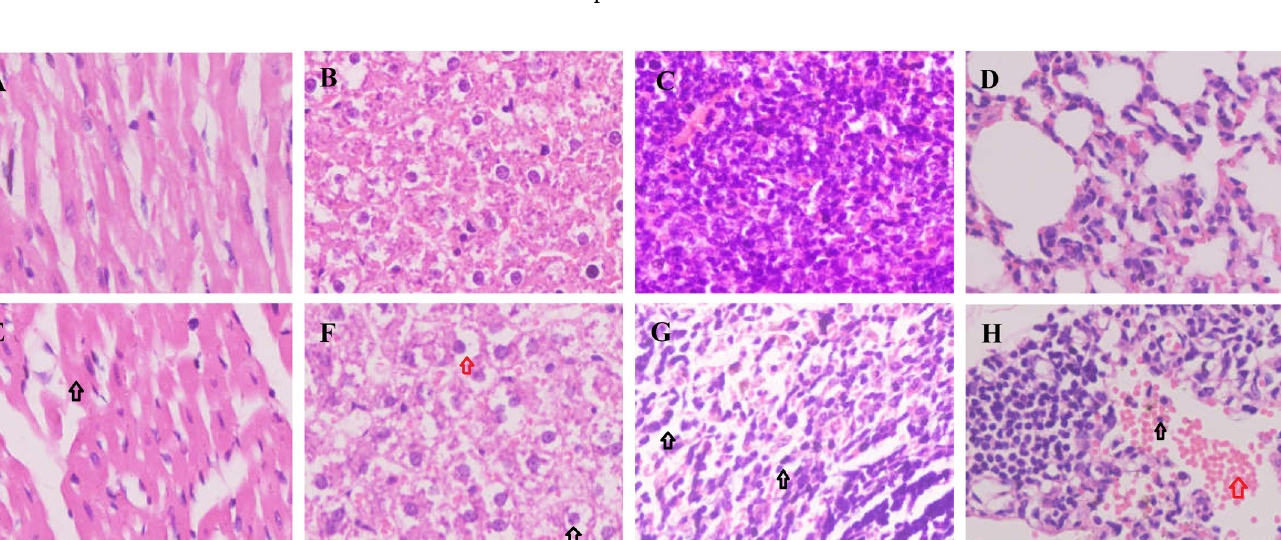
were found in their renal interstitium under polarized light [13]. In contrast to Uox -/- mice, the SUA level in Uox -/- rats was much lower, only similar to that in humans, and the urate crystals were not found in their kidneys. The results are understandable since urate crystals are seldom found in normal persons whose SUA level is similar to that of the Uox -/- rats.